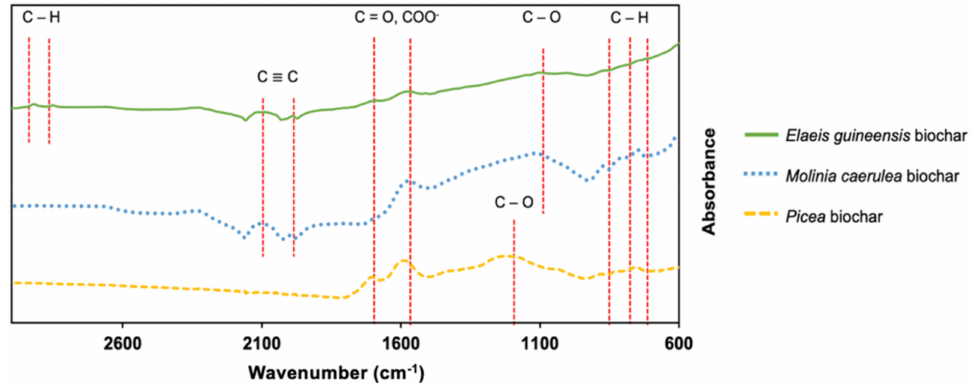
Figure 1. Picea , Molinia caerulea and Elaeis guineensis biochar FTIR spectra. The peaks at 744, 813, and 877 cm − 1 are associated with the carbon linkages, more specifically C–H bending, and the peaks at 1574 and 1700 cm − 1 are associated with carboxyl groups. Besides, the Molinia caerulea and Elaeis guineensis biochar shows a C–O group (1111 cm − 1 ) that corresponds to a secondary alcohol, while the Picea biochar shows the C–O group (1196 cm − 1 ) associated with a tertiary alcohol. These groups are mostly found in biochar that are obtained from sources that tend to be polar, hydrophilic, and relatively reactive, such as lignocellulosic feedstocks. Furthermore, the oxygen-containing functional groups have variable charge, at a higher pH, the carboxylic acids give up protons and become negatively charged (–COO − )